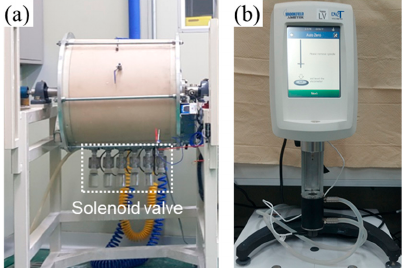
Figure 2. Target ball mill equipped for collecting experiment dataset and viscometer used to measure slurry viscosity: ( a ) Ball mill with the internal volume of 50 L and the interval diameter of 40 cm; ( b ) rotating disk viscometer (DV2TLV).